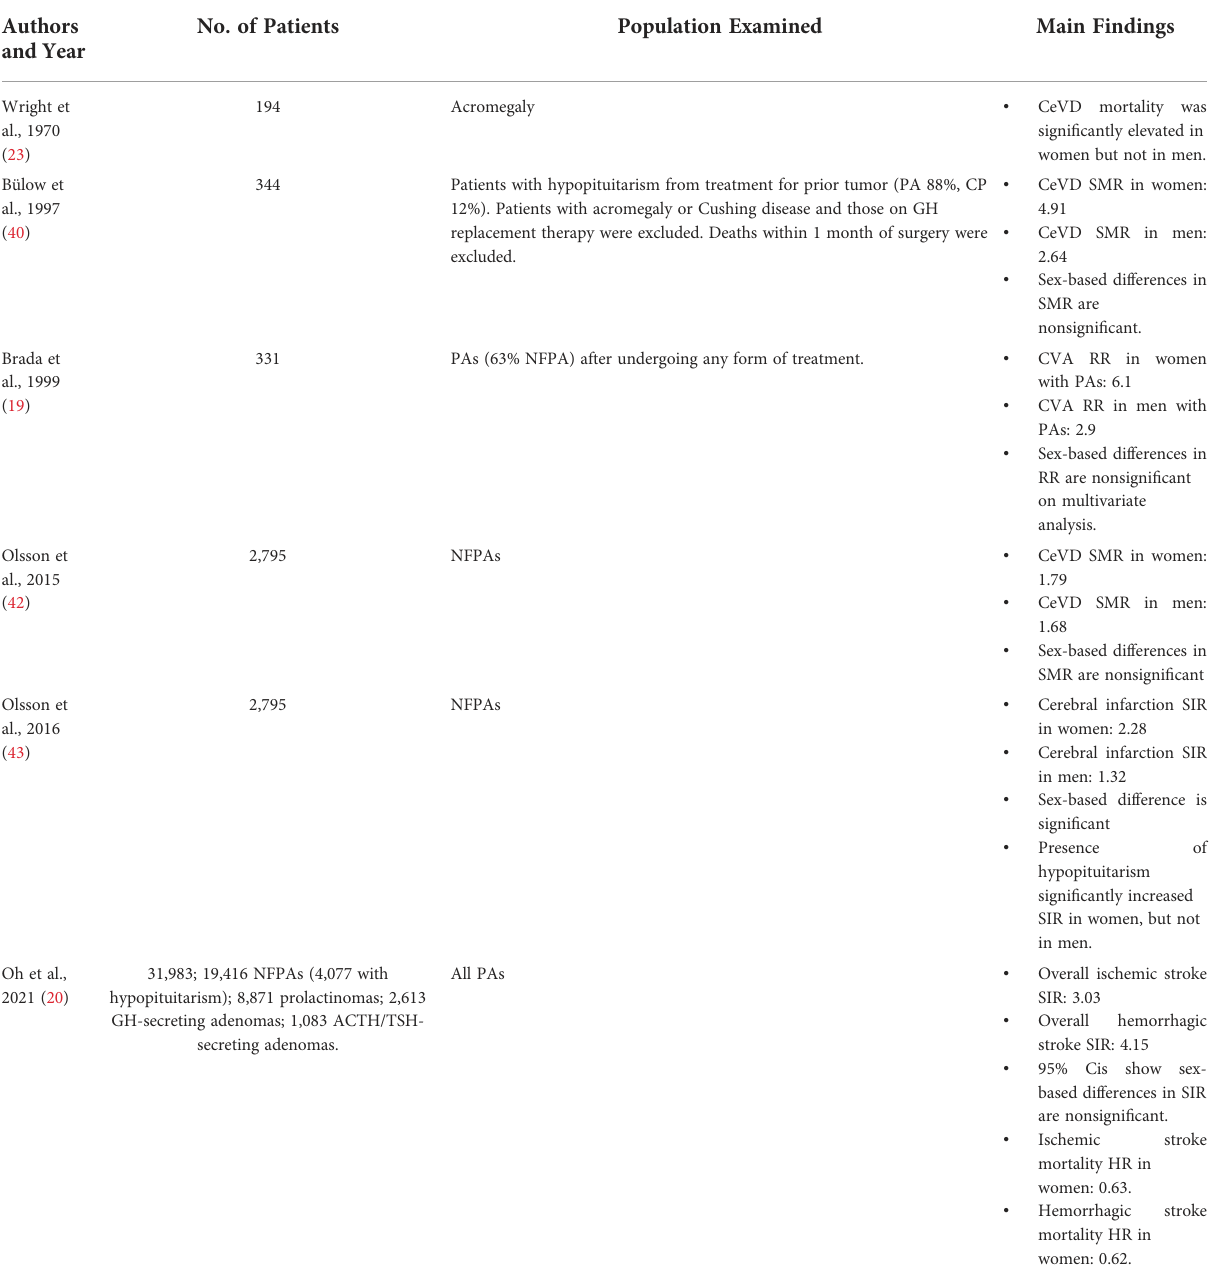
TABLE 4 Cerebrovascular outcomes related to PA patient